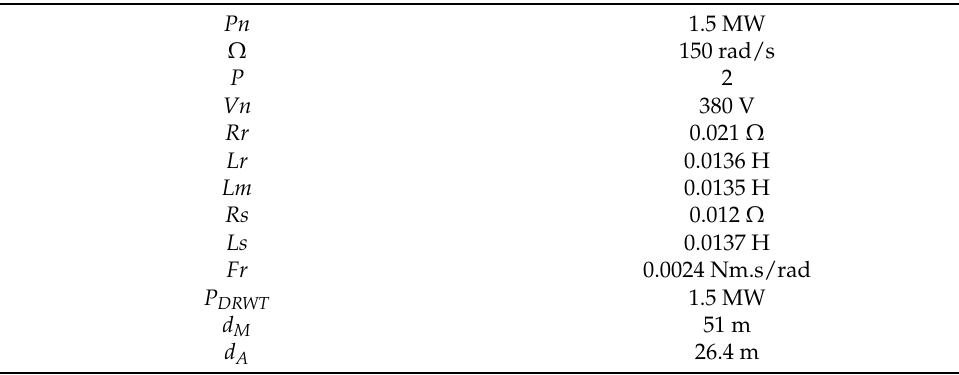
Table A1. ASG-DRWP